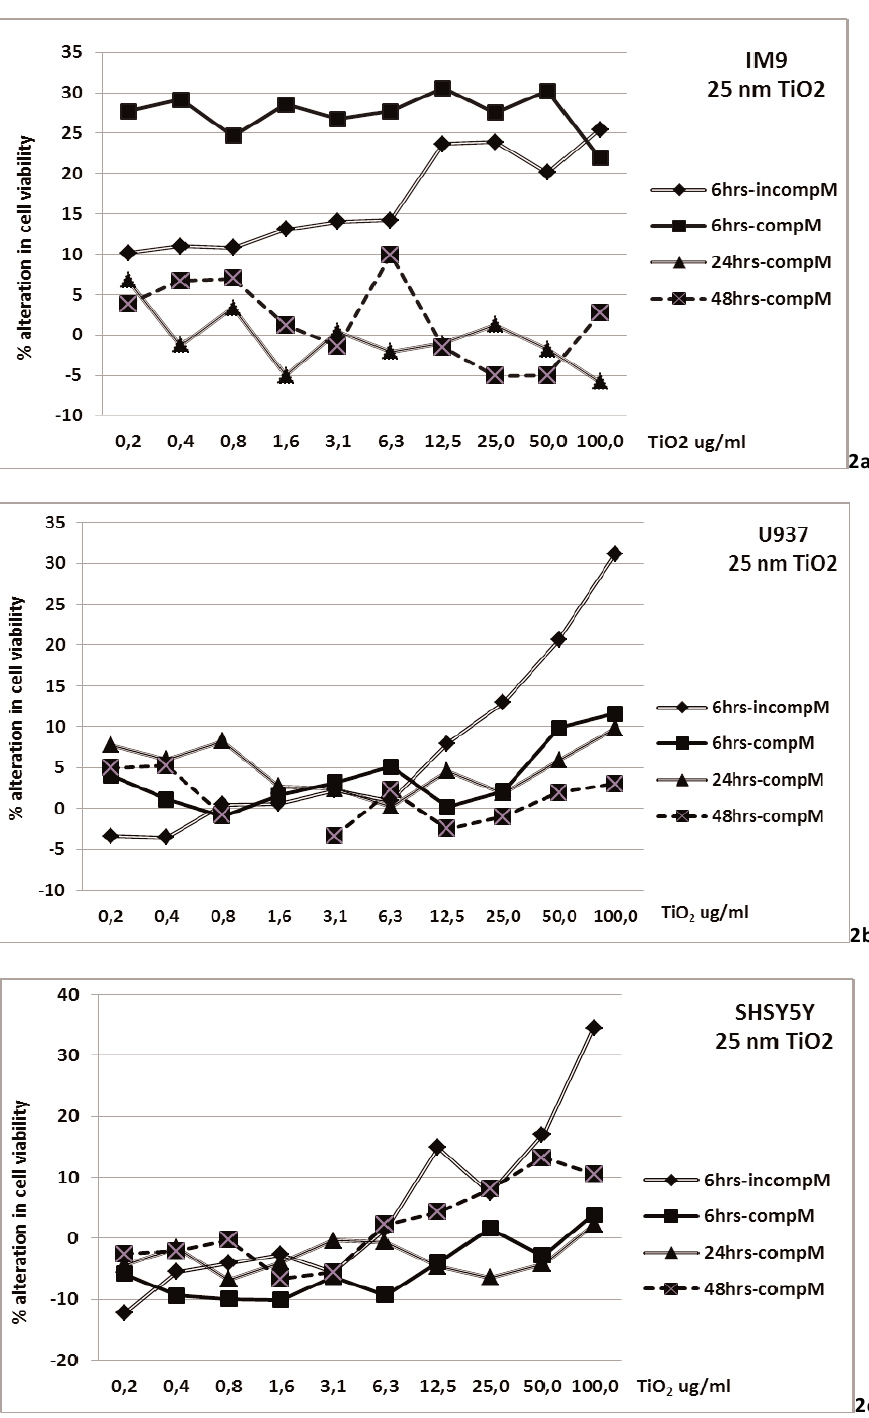
Figure 2.: % alteration in cell viability of IM9 (a), U937 (b) and SHSY5Y (c) cells after exposure to 25 nm TiO